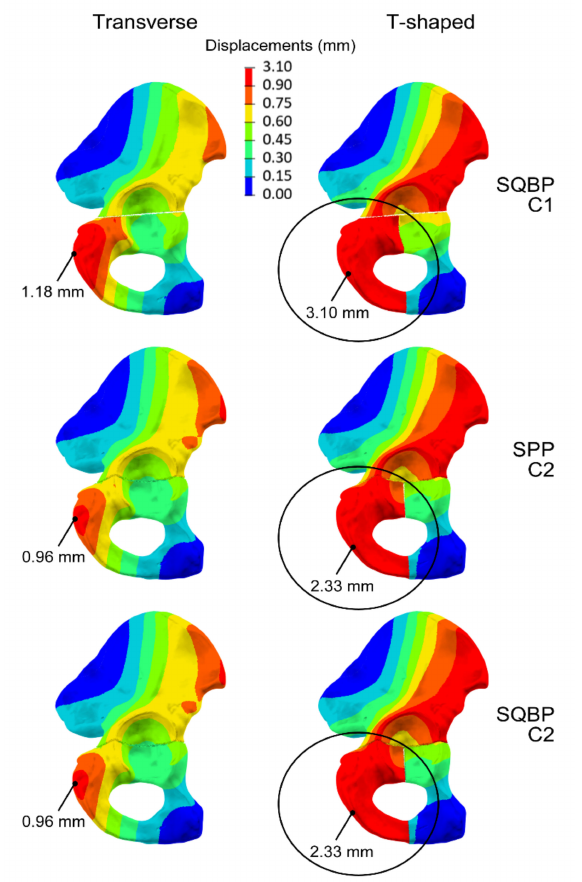
Figure 7. Displacement magnitude distribution in the six analyzed configurations: maximum value magnitude and location is shown for each model. Note that T-shaped fracture models show the less stable behavior, being the ischium region (black circles) the one subjected to major